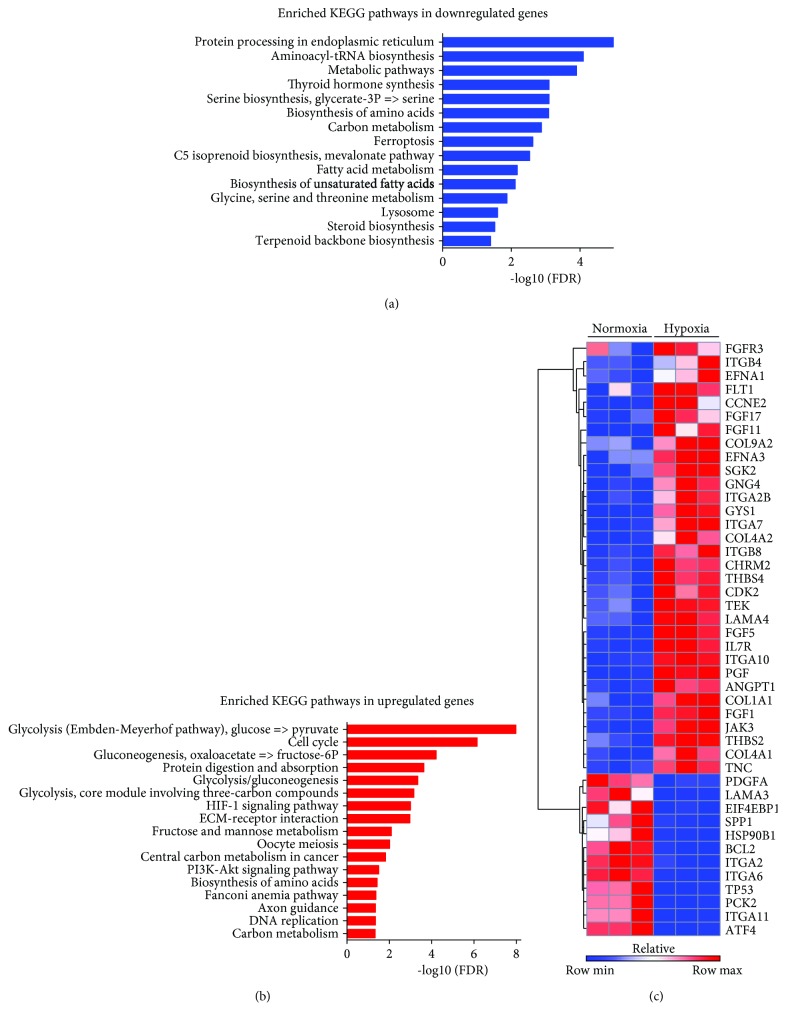
Differential expression analysis of hDPCs cultured between hypoxia and normoxia conditions: (a) top enriched pathways in downregulated genes of hypoxia condition; (b) top enriched KEGG pathways in upregulated genes of hypoxia condition; (c) heatmap shows expression of differentially expressed genes in the PI3K-Akt signaling pathway between hypoxia and normoxia conditions. Red indicates high expression, while blue indicates low expression.